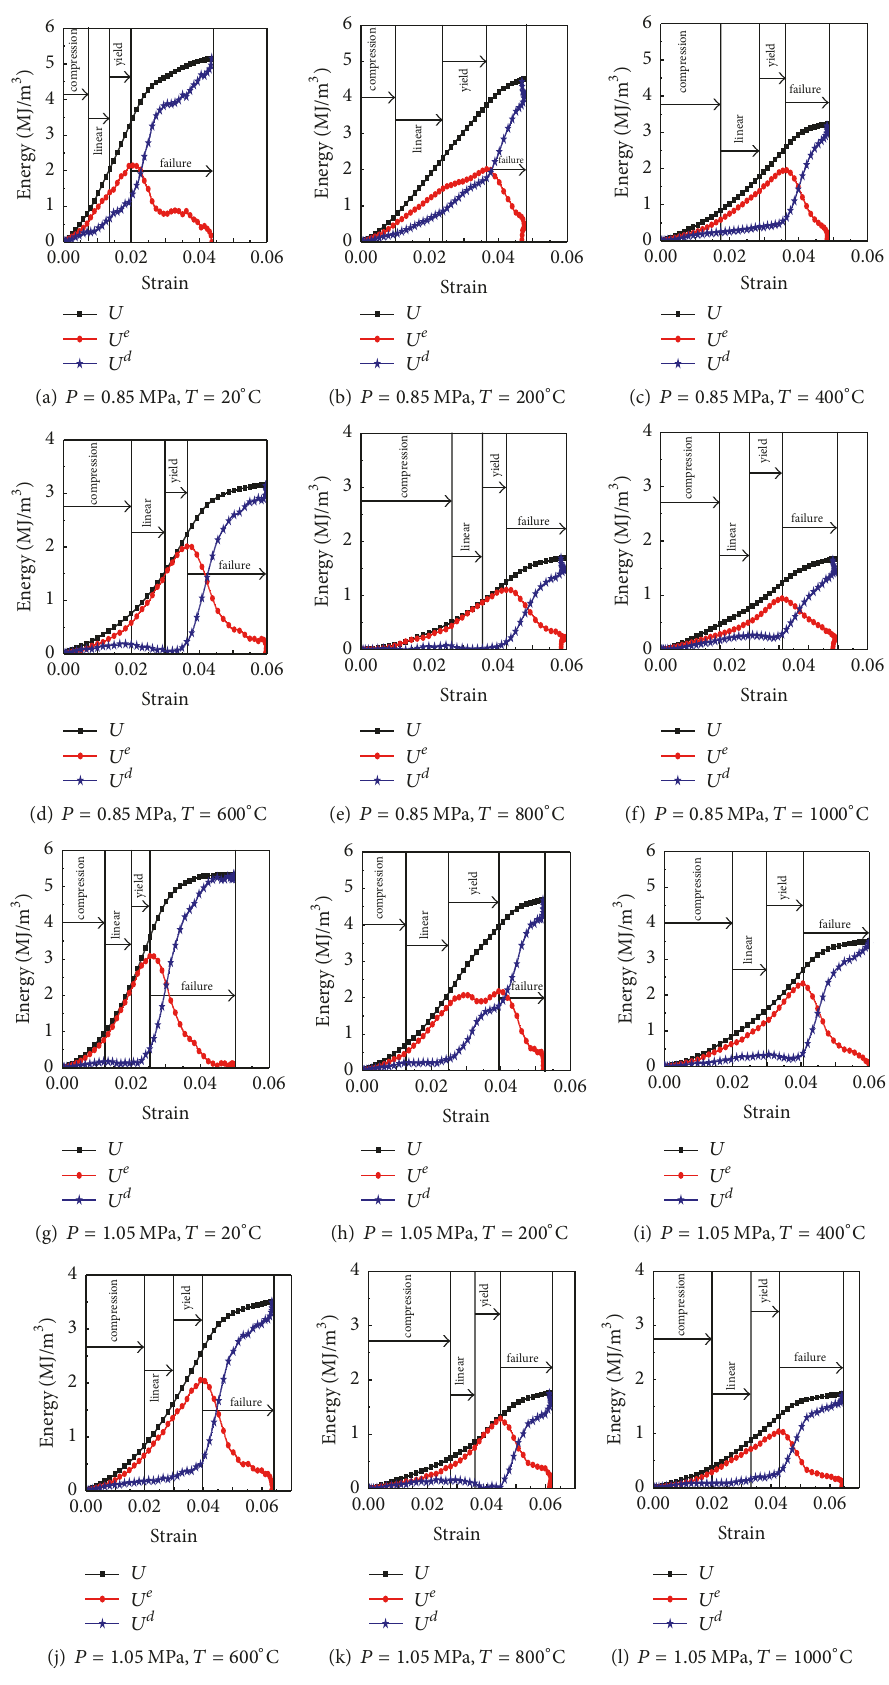
Figure 11: Energy evolution curves of sandstone after different temperature and impact